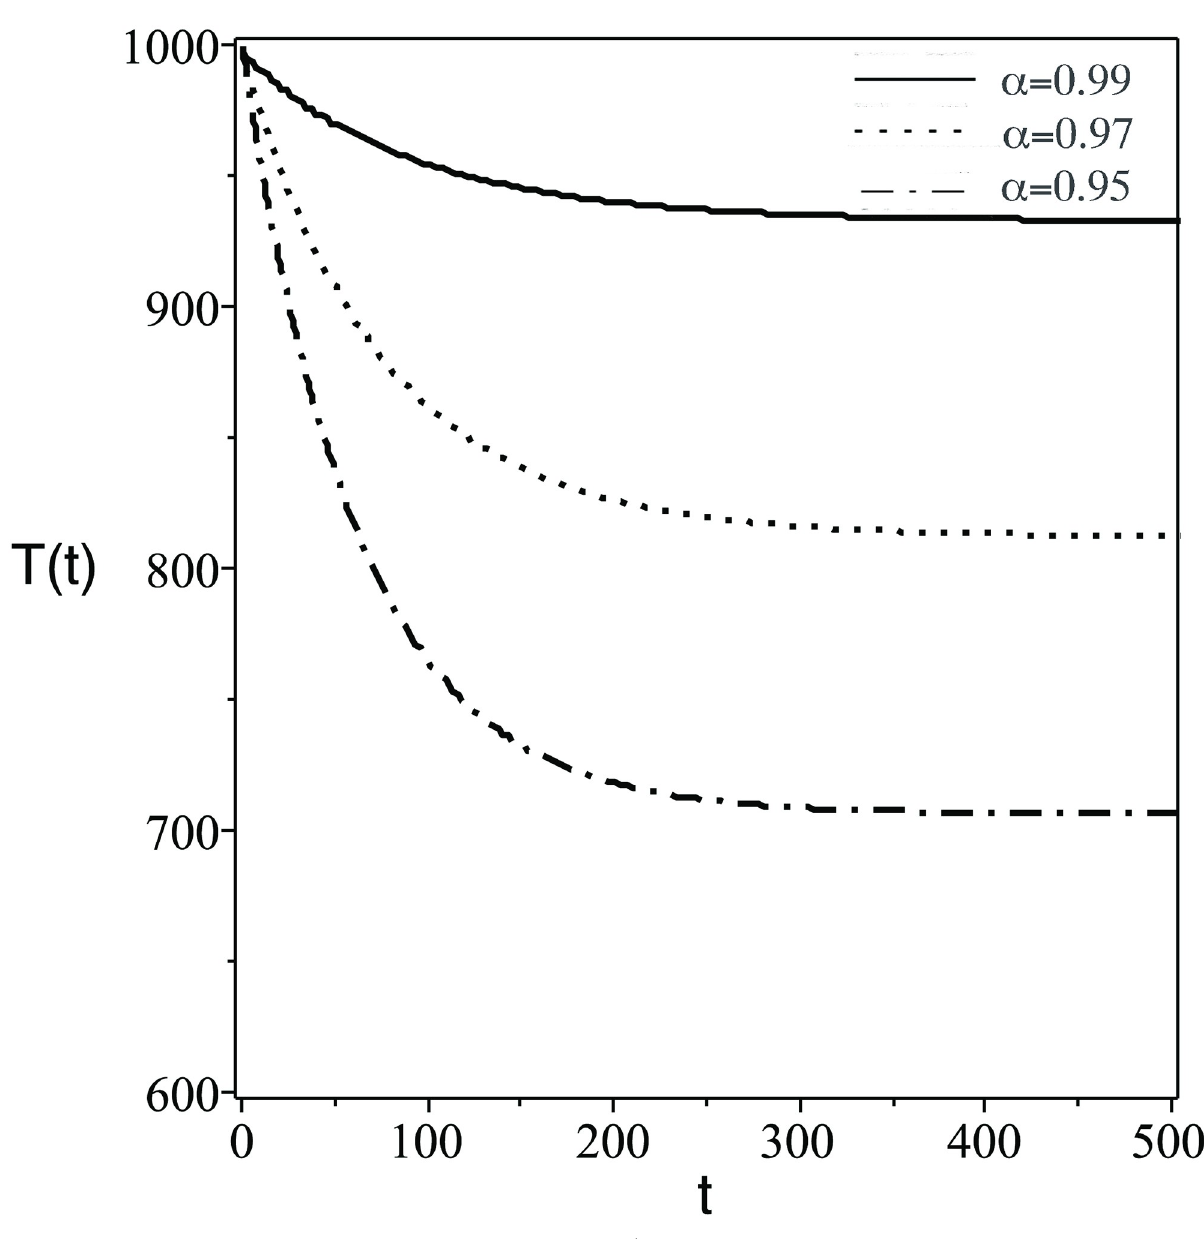
Fig 2. Same as Fig 1 but for the number of concentration of uninfected CD4 + T-cells, T ( t ).